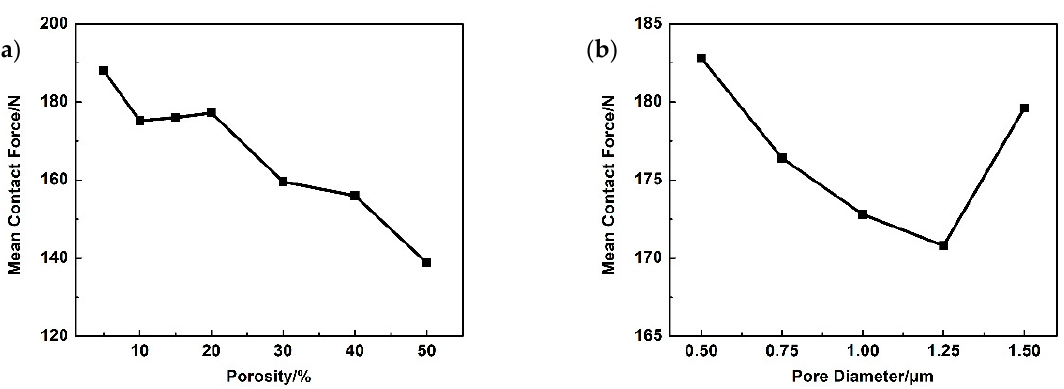
Figure 8. Plot of mean scraping contact force variation with porosity and pore diameters: ( a ) 1.5 µ m pore diameter, ( b ) 20% porosity.